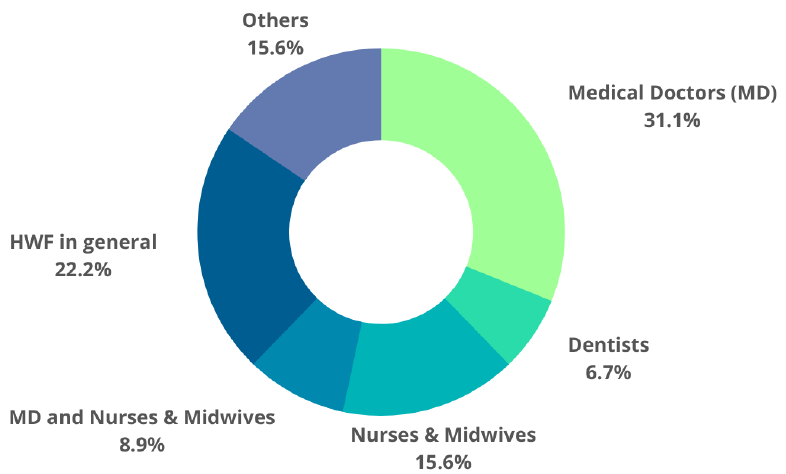
Figure 3. Distribution of professional groups covered by the